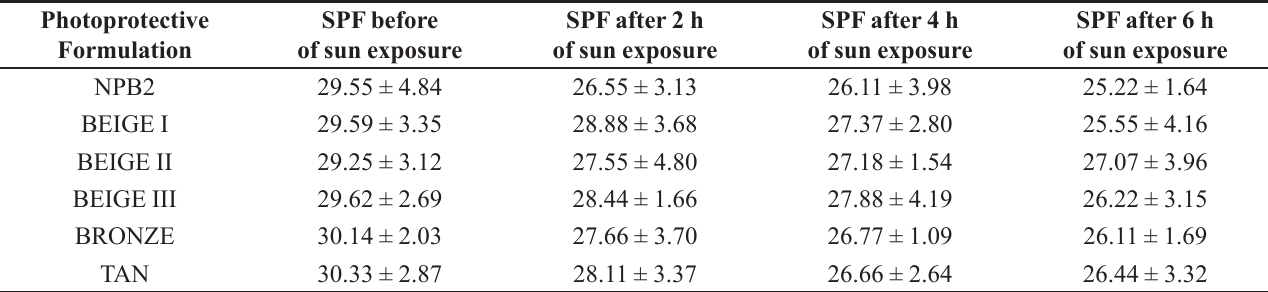
TABLE VII - SPF values of each photoprotective formulation, before and after 2 h, 4 h and 6 h of sun exposure, obtained by transmittance spectrophotometry using integrating sphere (Labsphere®)